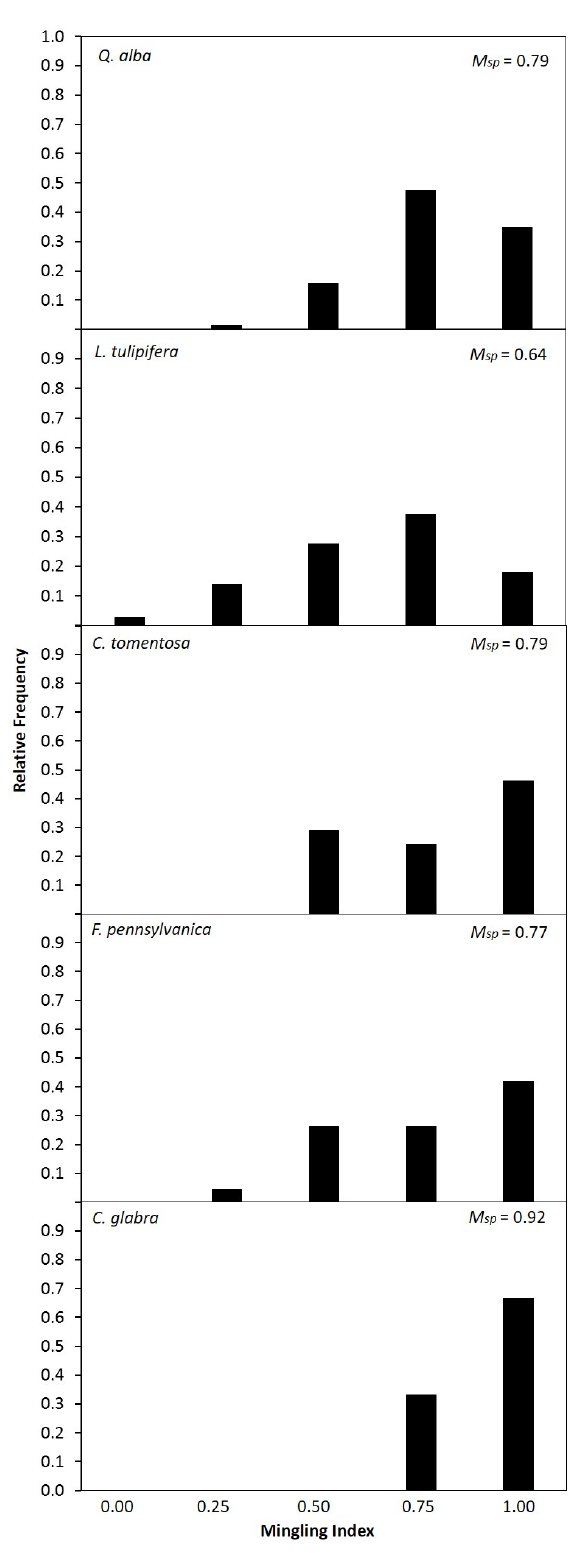
Figure 4. Histogram of M i values for the five most important species. A value of 1 indicates that the four nearest neighbors of a focal stem are different species from the focal stem. A value of 0 indicates the four nearest neighbors are the same species as the focal stem.